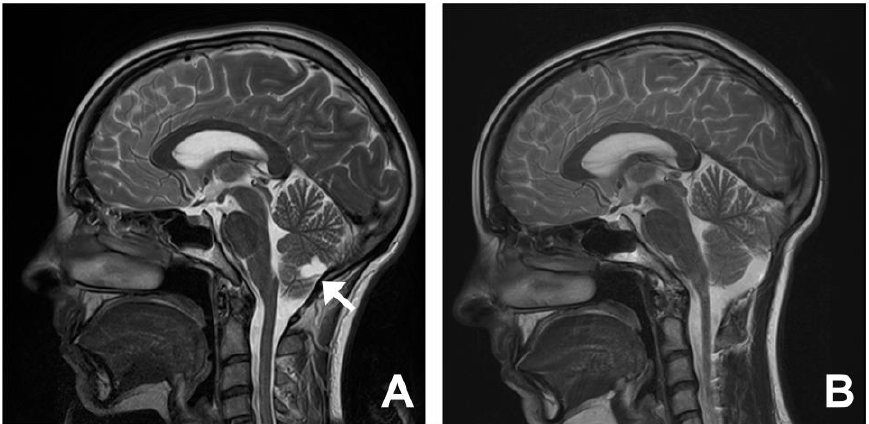
Figure 5. Chiari mimic: choroid plexus cyst. A 23-year-old woman presented with a 5-year history of headaches. An MRI demonstrated tonsillar descent and reduction in foramen magnum CSF space ( A ). There was an extra-axial cyst posteroinferior to the vermis between the cerebellar hemispheres (( A ); white arrow). At surgery, the cystic lesion was found to be connected to the choroid plexus. The cyst was excised in a single piece and subsequent histopathology confirmed a choroid plexus cyst. At follow-up, there was full resolution of the symptoms. An MRI showed a restoration of the cisterna magna and no evidence of recurrence of the choroid plexus cyst ( B ).